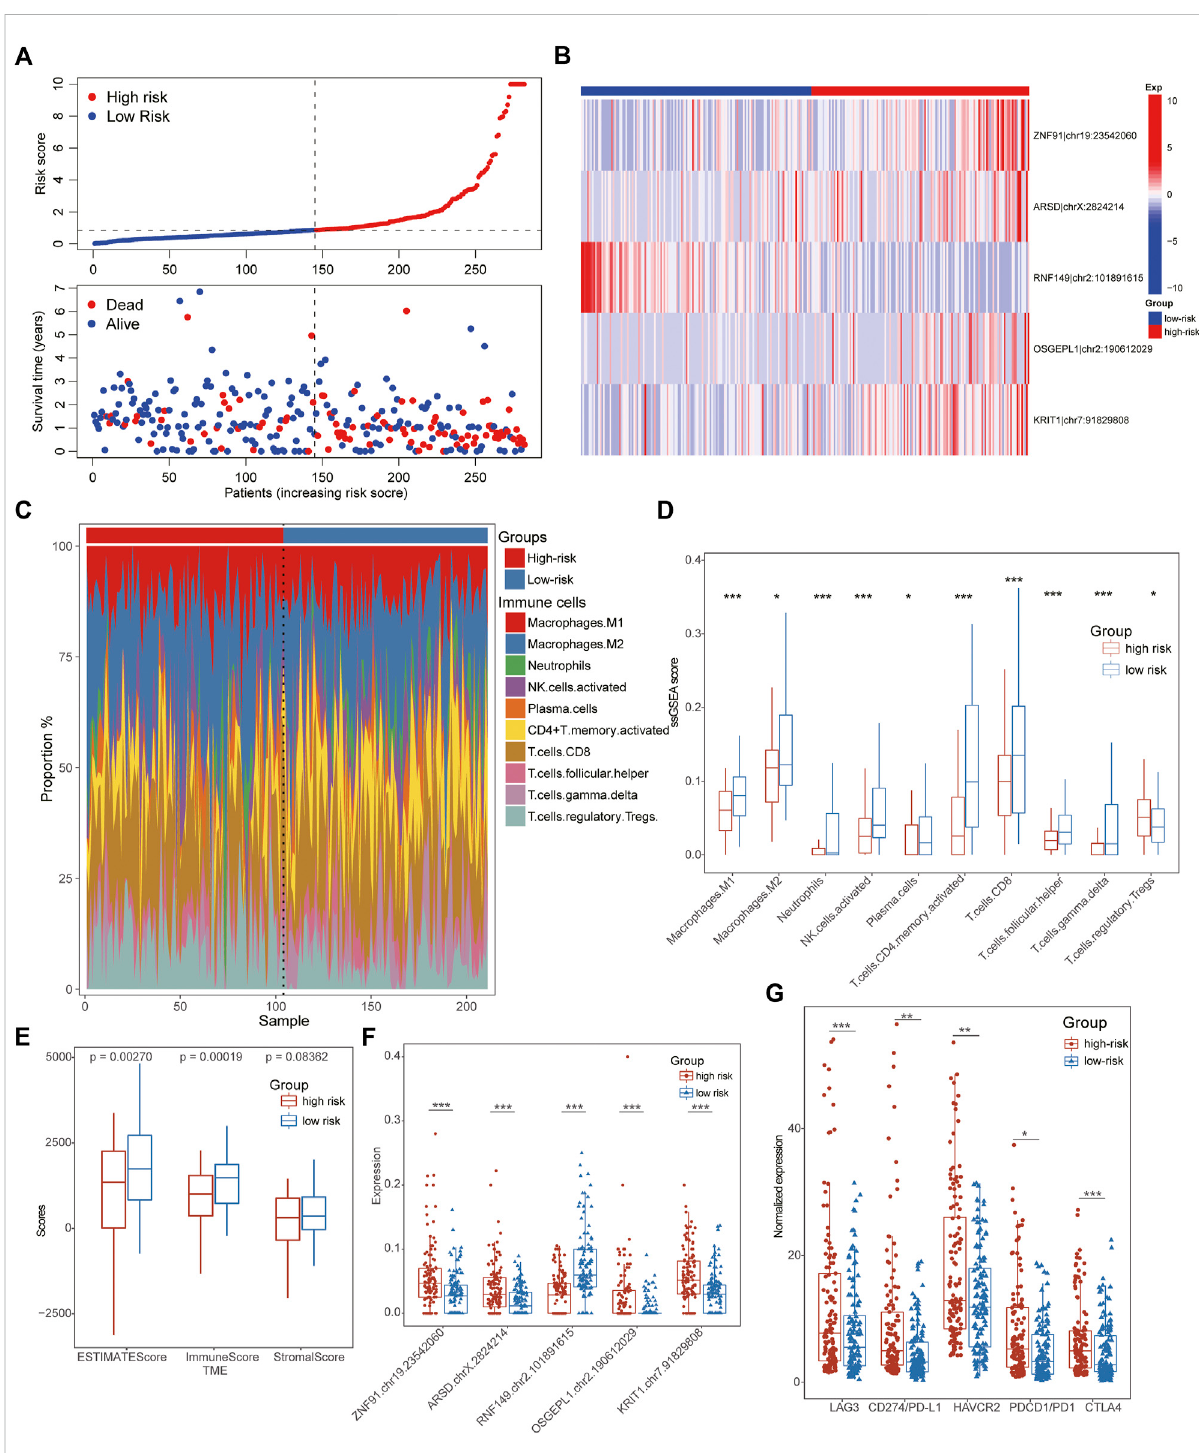
FIGURE 4 Immunological characteristics of ATIRE-related subtypes in STAD. (A) The number of death patients was increased with the increasing of Risk scores. (B) The heatmap showing editing frequencies of fi ve hub ATIRE sites between low- and high-risk patients. (C) The scale charts showing the different in fi ltrate ratios of immune cells between low-risk and high-risk subgroups. (D) Multiple immune cells were in fi ltrated in the tissues of low- riskGCpatients,suchasMacrophages,activatedNKcells,CD4 + T-cells,CD8 + T-cells,Plasmacellsandsoon. (E) TMEanalysisdisplayedthatthe low-risk patients exhibited higher immune and stromal scores than that of high-risk STAD patients. (F) Box line diagrams showing the different expression of fi ve hub ATIRE sites between low- and high-risk patients. (G) The low-risk patients possessed a lower expression of immune- checkpoints than high-risk groups, including LAG3, HAVCR2, CTLA4, PD1/CD274, and